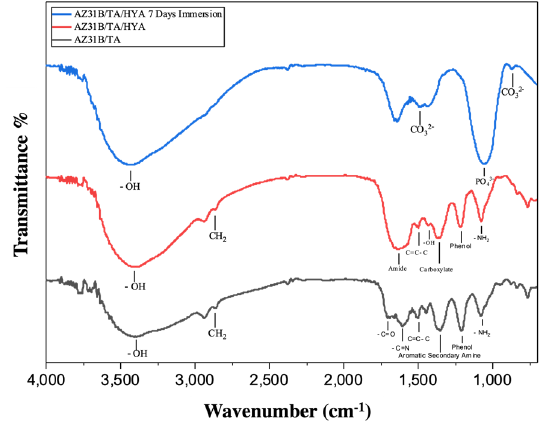
Figure 2. FTIR characteristics of AZ31B, AZ31B/TA, and AZ31B/TA/HYA, after seven days SBF immersion. Table 4. Identification results of functional groups in the sample after seven days of SBF